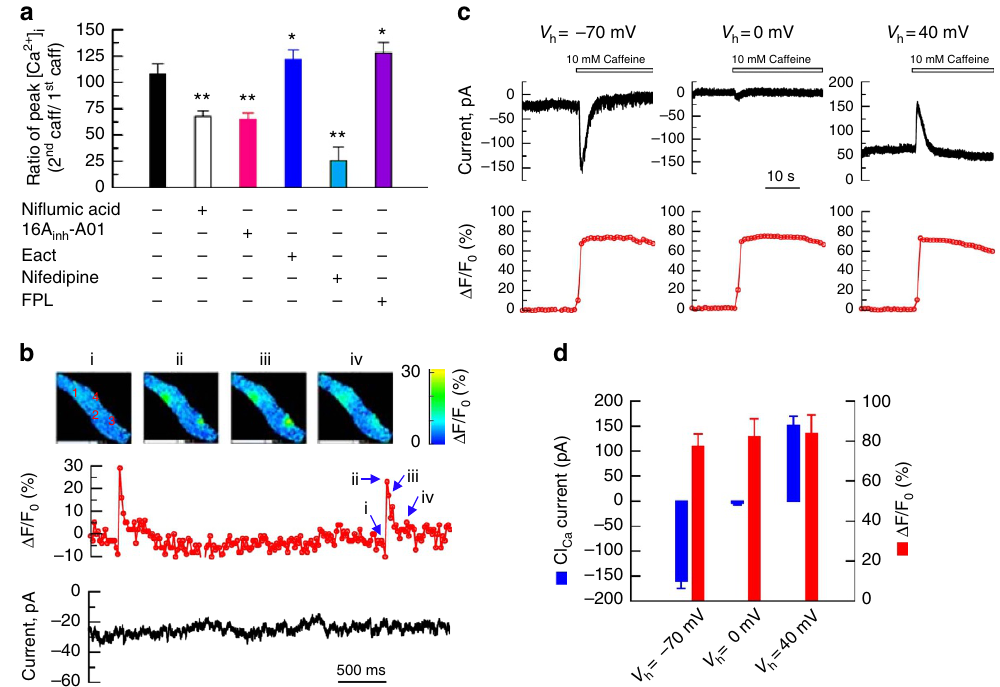
Figure 4 | RyRs, Cl Ca channels and VDCCs form a signaling module in IAS-SMCs. ( a ) Niflumic acid (100 m M), 16A inh- A01 (10 m M) and nifedipine (1 m M) partially inhibited, while E act (30 m M) and FPL64176 (0.1 m M) potentiated, a caffeine (1mM)-induced calcium increase. Data were calculated as the ratio of increase in Ca 2 þ by a second caffeine pulse over the first caffeine pulse. For each group, cells were pretreated with the modulator for B 3min before the application of the second caffeine pulse. Bars represent mean ± s.e.m., n ¼ 3–8, * P o 0.05; ** P o 0.01 versus caffeine alone group by two-tailed Student’s t -test. ( b ) Individual sparks do not activate any Cl (cid:2) currents. Top panel shows the spatiotemporal evolution of two Ca 2 þ sparks (sites marked 1 and 3) in an IAS-SMC, below it is the associated time course for site 3 calculated as D F/F0 (%), that is, the change in [Ca 2 þ ]i from the spark’s epicentre pixel, 330 (cid:3) 330nm, divided by its value from time 0. Images are displaying D F/F0 (%). Roman numerals on the time course are the time points of the four images on the top panel from site 3. Sites 2 and 4 displayed sparks at times not shown in this analysis. The lowest panel is the membrane current associated with these Ca 2 þ sparks. Note that none of the events is associated with membrane current changes, that is, no STICs (that is, spontaneous transient inward currents) were evoked by Ca 2 þ sparks. ( c ) Caffeine (10mM) increased global Ca 2 þ and Cl Ca currents. The currents reversed at E Cl ( B 0mV), which indicates that the currents detected at (cid:2) 70 and þ 40mV are due to the opening of Cl Ca channels. ( d ) Summarized results for the 10mM caffeine-induced global Ca 2 þ increases and their corresponding Cl Ca currents at (cid:2) 70, 0 and þ 40mV. Bars represent mean ± s.e.m., n ¼ 4 cells, one from each of four